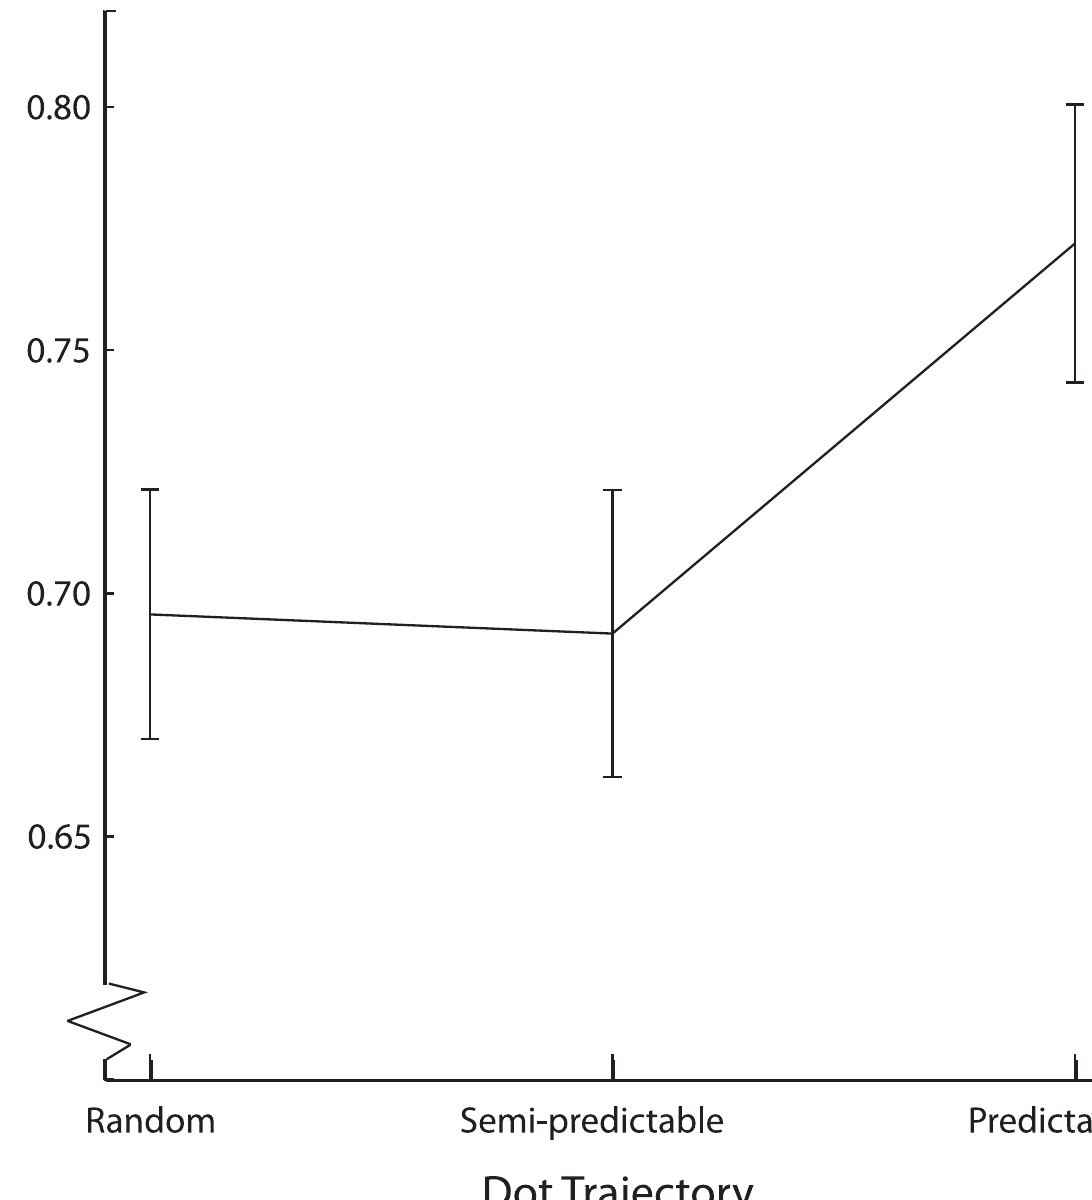
PLOS ONE | https://doi.org/10.1371/journal.pone.0180573 July 10,